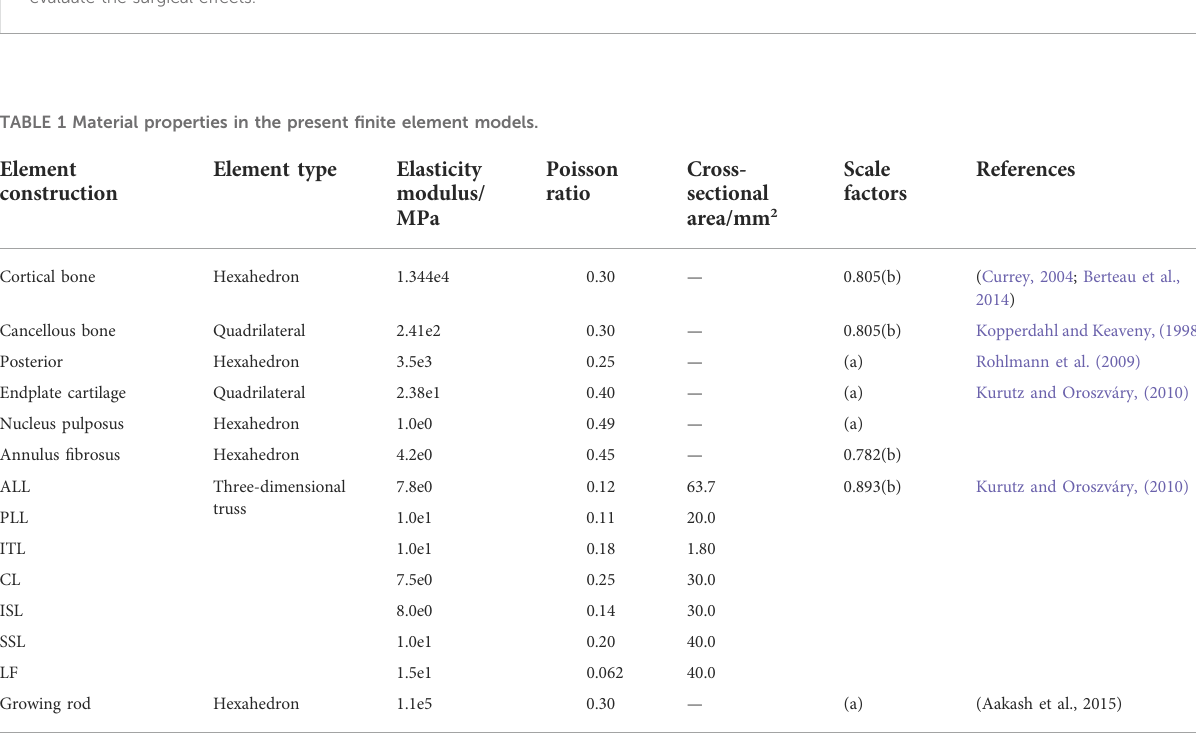
coupled and applied a pure torque (0.5, 1.0, 1.5 and 2.0 Nm) in fl exion and extension directions. The lower surface of C7 was bound with the ground. Finally, the angular displacement of the C6-C7 segment was achieved and it displayed that the average error between the experiment and simulation in fl exion and extension is 5.7%